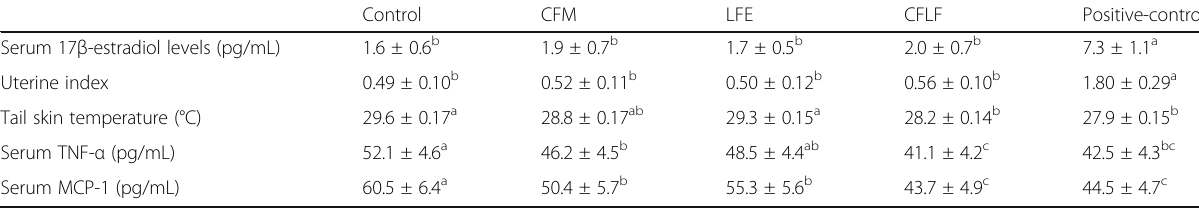
Serum MCP-1 (pg/mL)